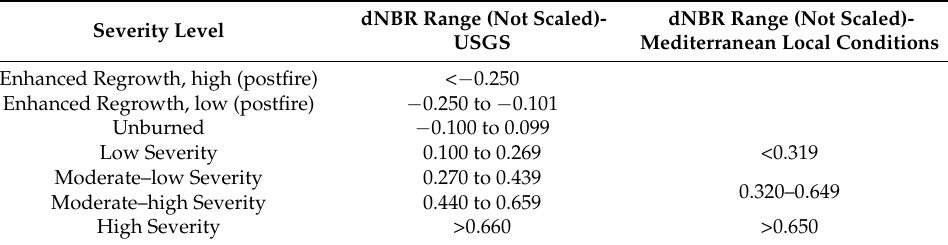
Table 3. Fire severity